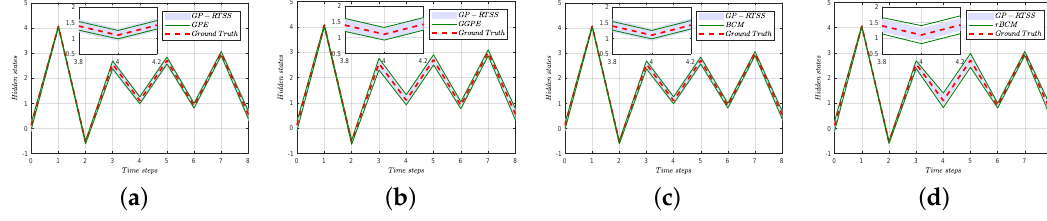
Figure 4. Comparison of four data fusion methods for distributed hidden-state identification. In each subfigure, the confidence interval of the comparison algorithm is filled between two green lines. Furthermore, the GP-RTSS (full GP) to be approximated is shown in the blue shaded area, representing 95% of the confidence interval, and the ground truth is given in the red dashed line. ( a ) PoE; ( b ) gPoE ; ( c ) BCM; ( d )